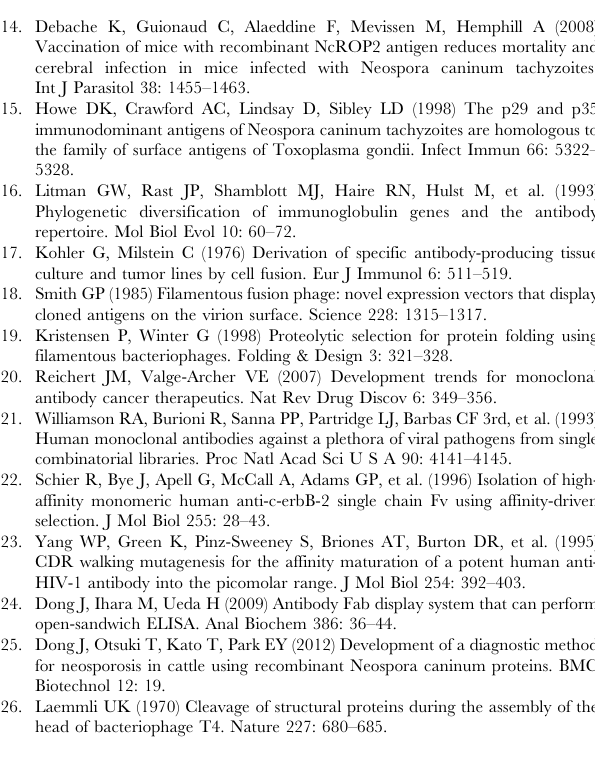
Table S1 Primers used in this